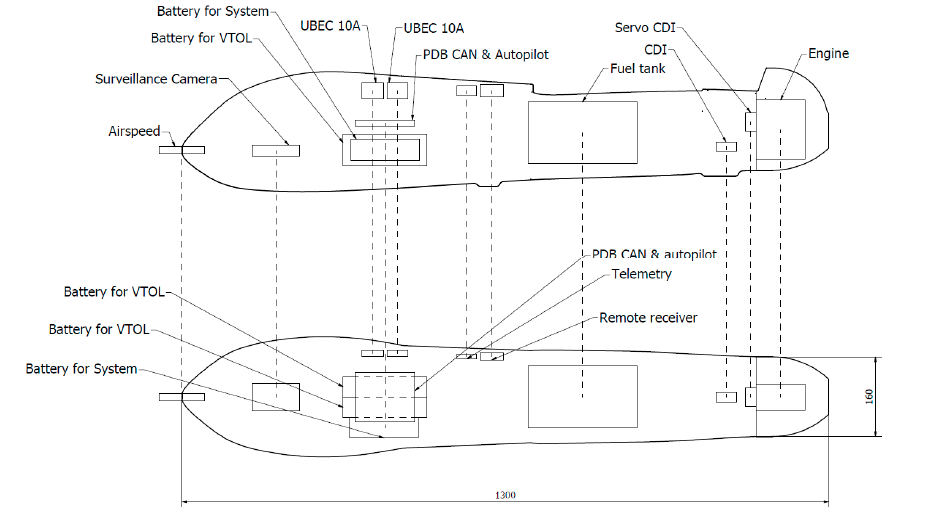
Figure 5. Payload position on the fuselage.